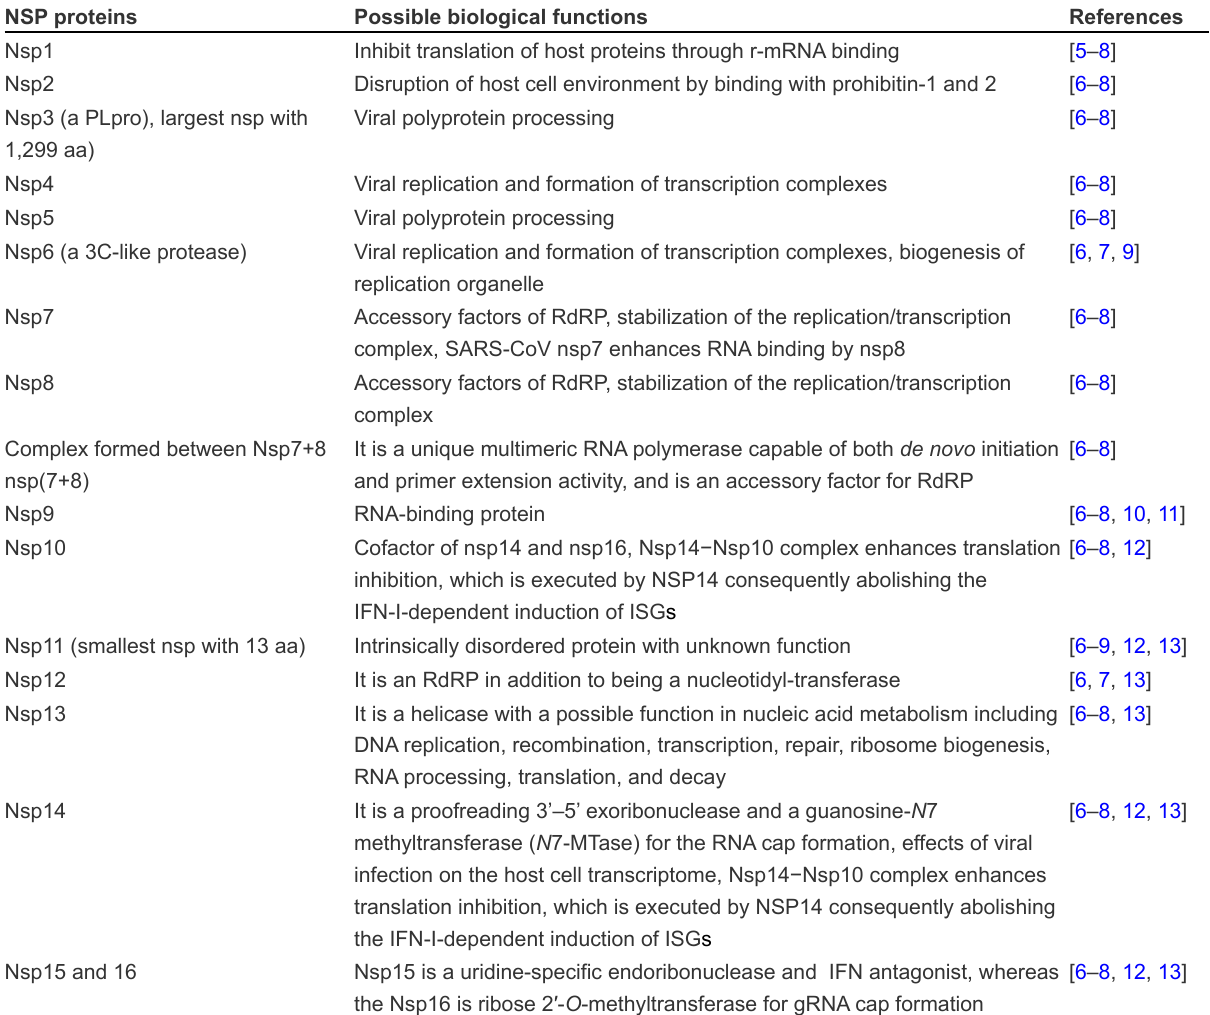
Table 1. Functions of NSPs encoded by ORF1a and 1b of SARS-CoV-2 NSP proteins Possible biological